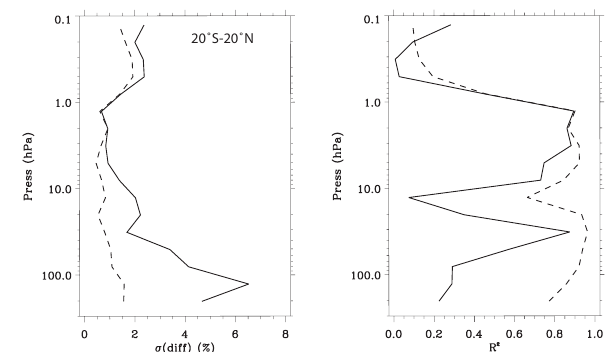
Figure 16. Standard deviation of difference and anomaly correlation, plotted as R 2 , between NOAA-17/SBUV and Aura/MLS derived using 6 years of MZMs at 45˚N (2005-2010). The solid lines show unsmoothed data, the dashed lines smoothed data. Smoothing has large effect in layers where the DFS is small, except in the mesosphere, where the diurnal effects appear to be more important.